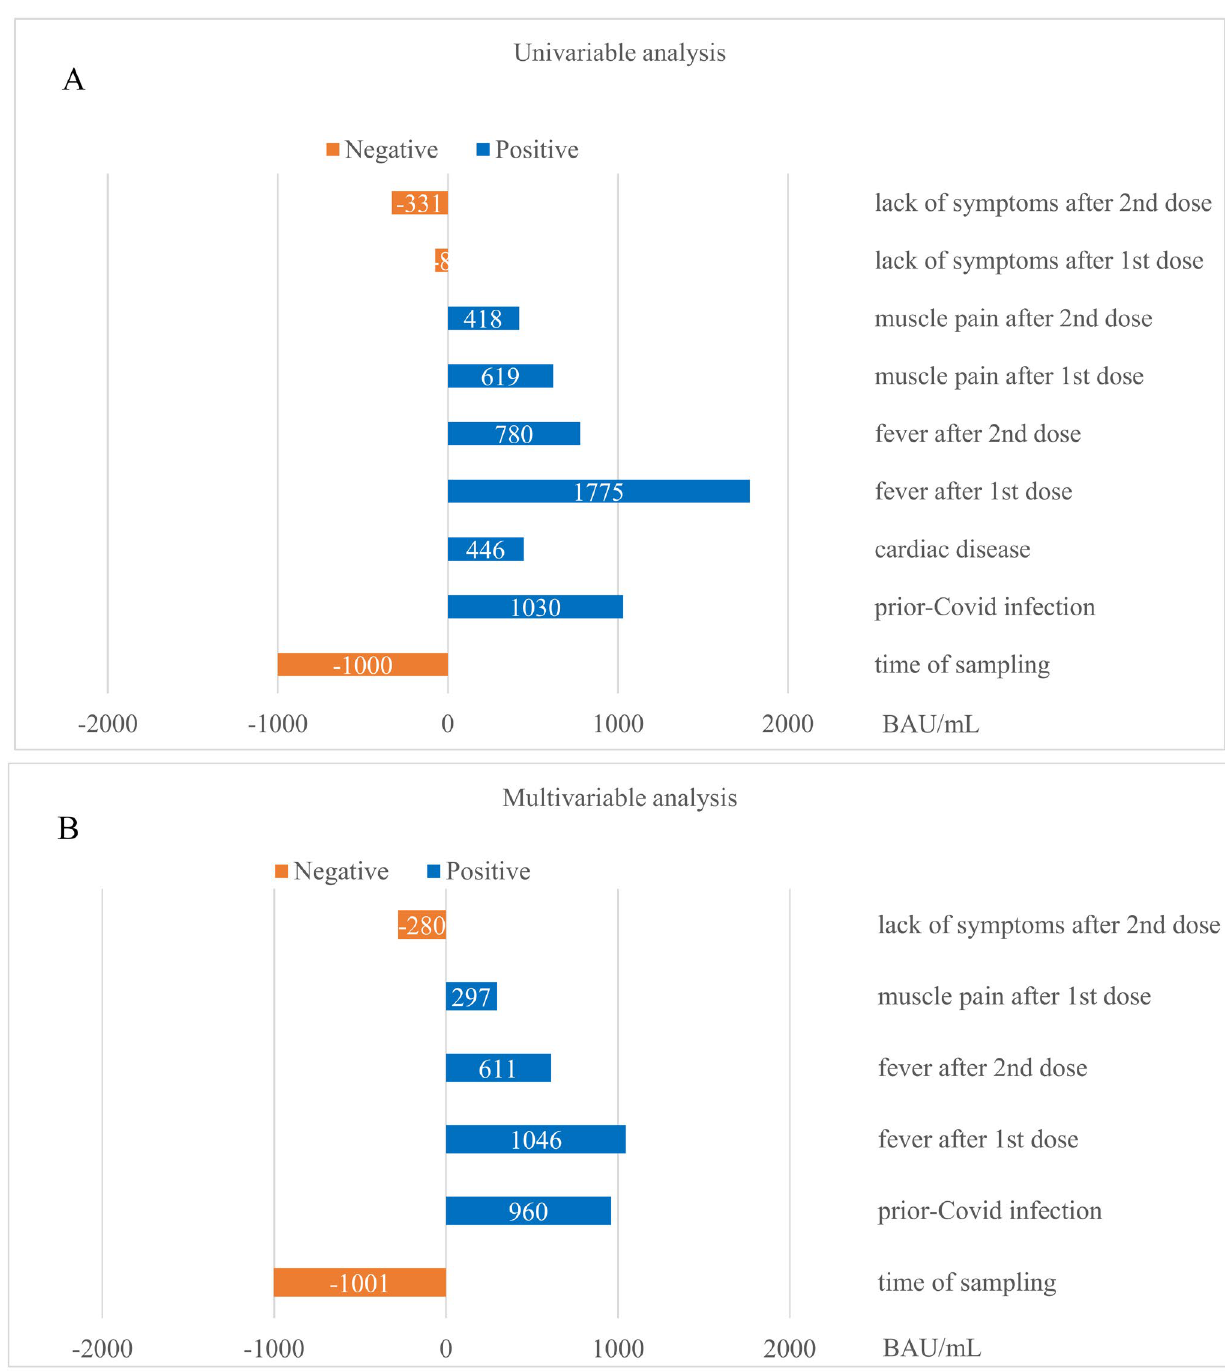
Figure 4. Quantitative impact of determinants on SARS-CoV-2 IgG concentrations, shown as an average absolute change in antibody levels expressed in BAU/mL for each statistically significant determinant: ( A ) in the univariable model, and ( B ) in the multivariable model.